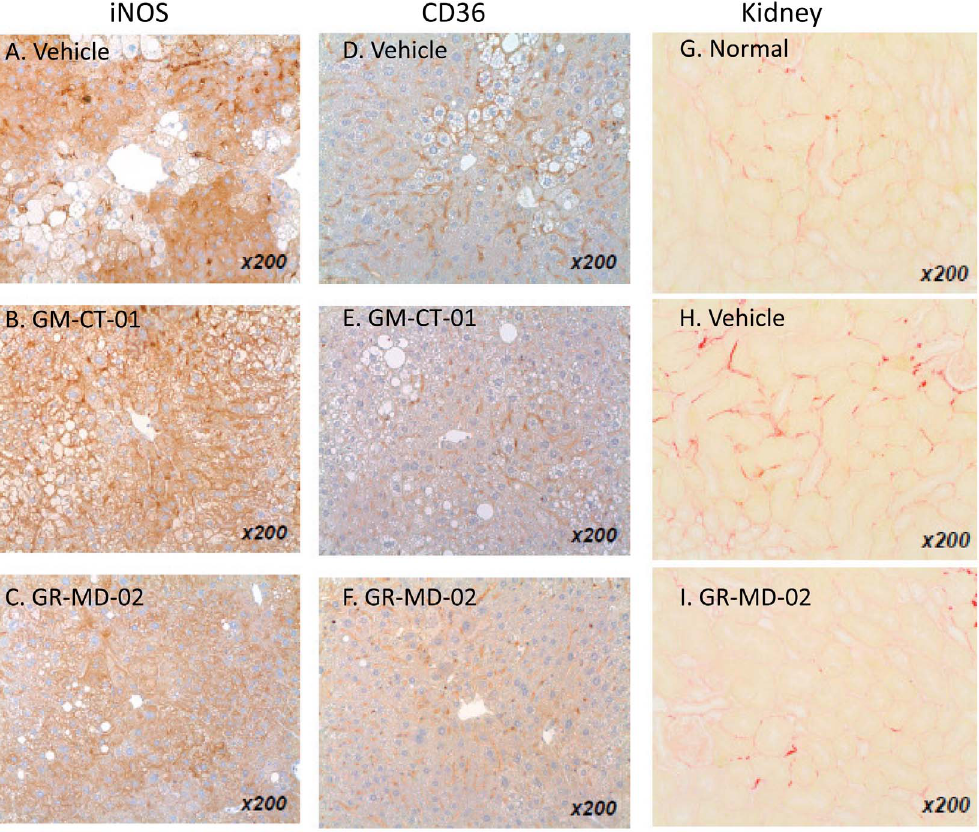
Figure 8. Liver immunohistochemistry and kidney collagen staining. Immunohistochemistry on animals as described in Figure 6. A–C: iNOS; D–F: CD-36; G–I: kidney sections stained with Sirius red from normal animals or animals treated with vehicle or GR-MD-02 (40 mg/kg three times weekly intravenously from weeks 6–9).